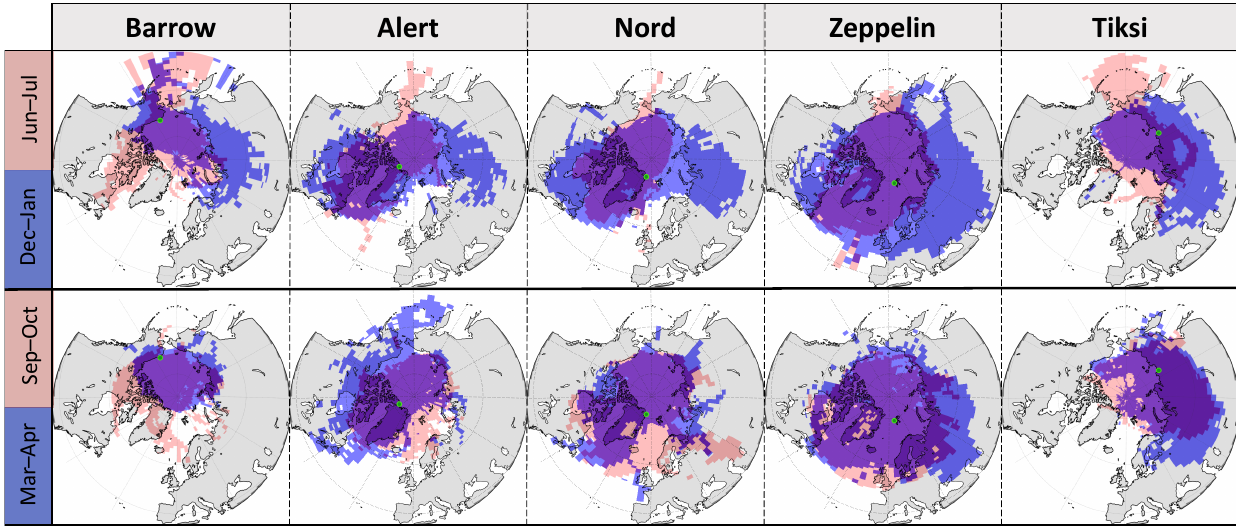
Figure 12. The seasonal areal coverage of 240h long back-trajectories for each of the sites. The top maps compare winter and summer in blue and red, respectively, while the bottom maps compare the spring and autumn. Only grid cells with a trajectory-crossing probability greater than 0.5% are